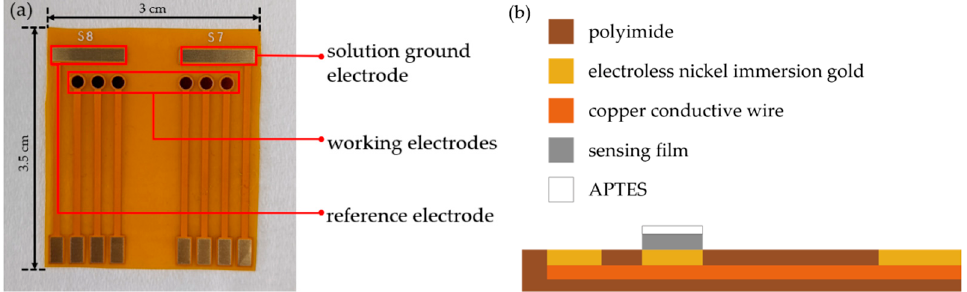
Figure 1. The ( a ) top view and ( b ) cross-section view of the pH